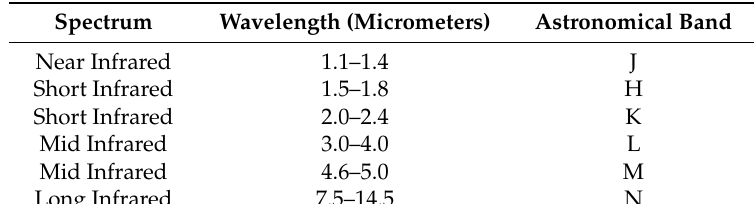
Table 1. Main window from short infrared to long infrared.